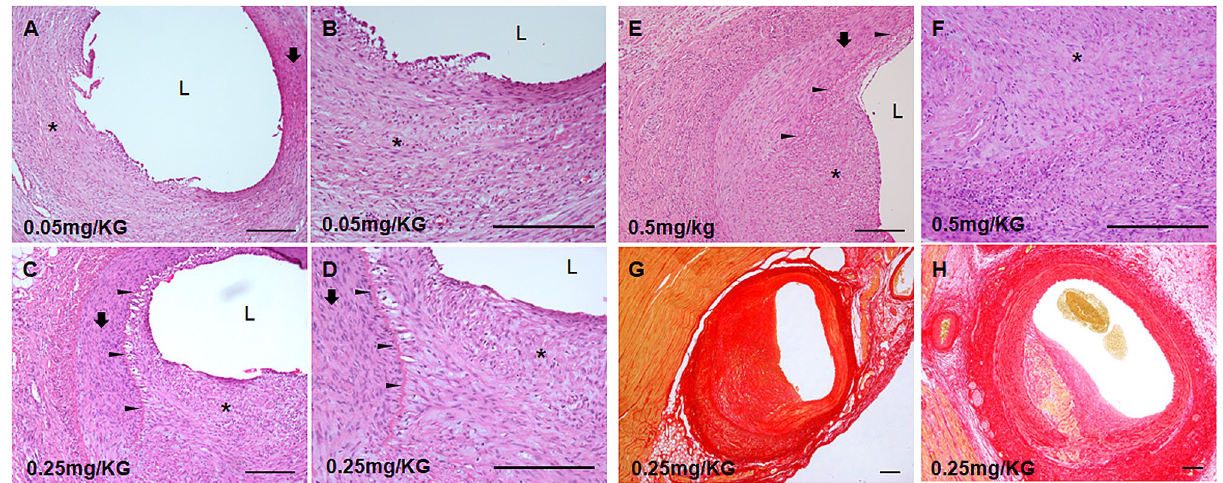
Figure 2. Hyperplasia of the coronary arteries after nicotine injection with balloon overdilation. ( A , B ) The dose of 0.05 mg/kg nicotine with balloon overdilation delayed the healing of the injured internal elastic lamina and induced the proliferation of the tunica media. ( C , D ) The dose of 0.25 mg/kg nicotine injection with balloon overdilation induced clear intimal hyperplasia compared to that seen in the lower dose and simple balloon overdilation groups. ( E , F ) The dose of 0.5 mg/kg nicotine injection with balloon overdilation induced intimal hyperplasia similar to the 0.25 mg/kg nicotine injection with balloon overdilation. ( G ) Picrosirius red staining results showed collagen positive intimal hyperplasia in the 0.25 mg/kg nicotine with balloon overdilation groups at 4 weeks. ( H ) Lack of collagen positive was observed in the 0.25 mg/kg nicotine with balloon overdialtion groups at 8 weeks. L lumen, arrow head: internal elastic lamina, arrow: tunica media, star: intimal hyperplasia. Bar: 100 µm.